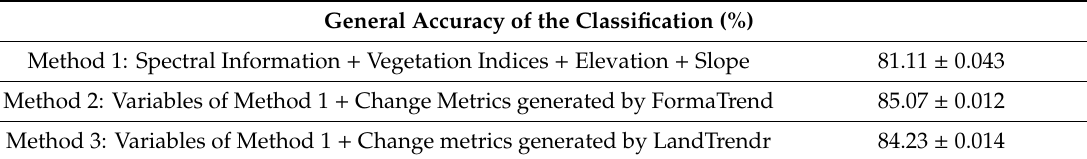
Table 1. Overall accuracy of the Landsat Time Series (LTS) classification using di ff erent methods.